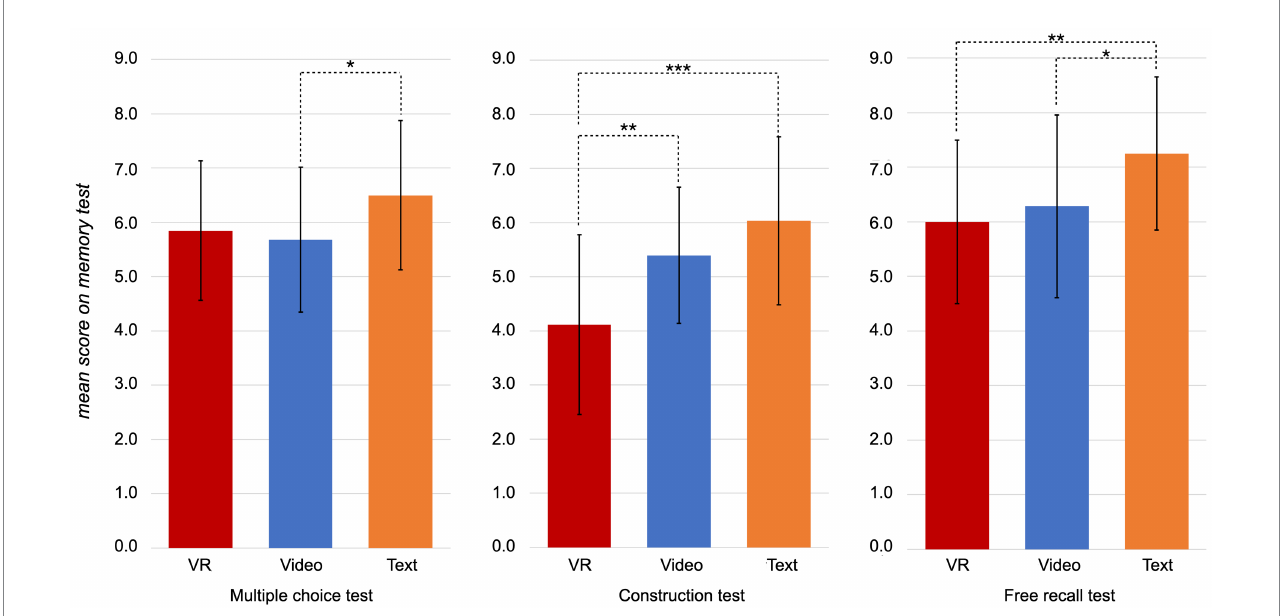
FIGURE 5 Mean scores of the achieved points in the respective memory task per group. The error bars depict the standard deviation from group mean. Significant differences between groups are marked, respectively, (* p < 0.05, ** p < 0.01, *** p <